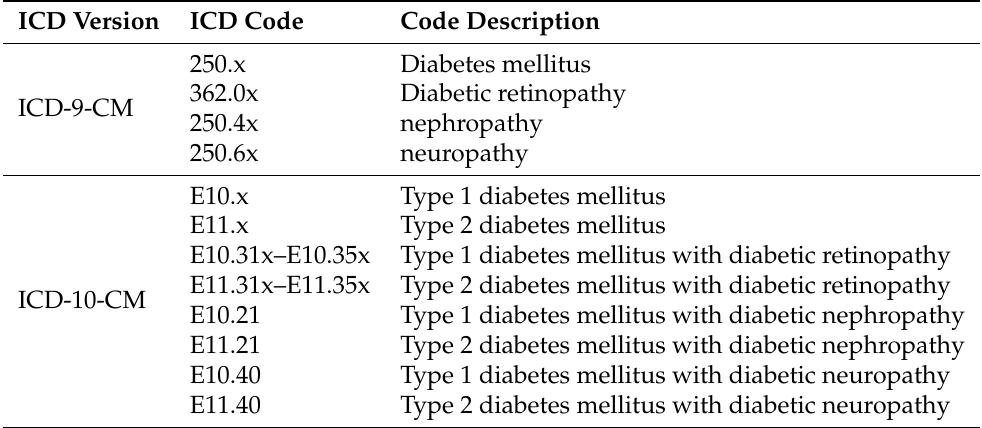
Table 1. International Classification of Diseases, Ninth and Tenth Revisions, Clinical Modification (ICD-9/10-CM) codes of diabetes and associated complications.